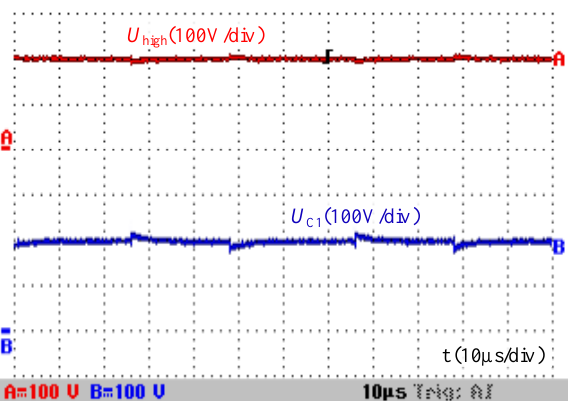
Figure 14. Output voltage and capacitor voltage stress when U low = 25 V.